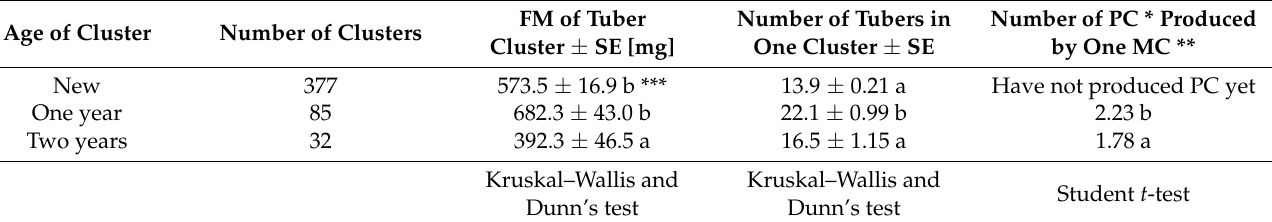
Table 1. The fresh matter (FM) of tuber clusters, the number of tubers in one cluster, and number of progeny clusters (PC) for different age clusters in the years